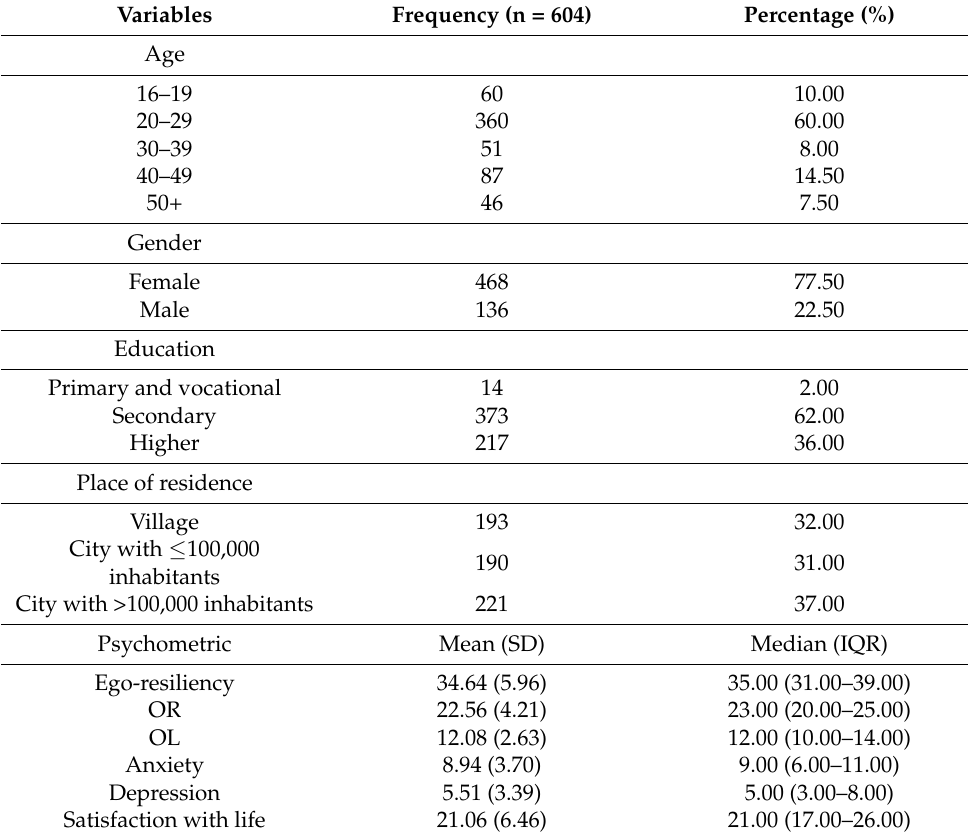
Table 1. Sociodemographic characteristics of the study group and descriptive